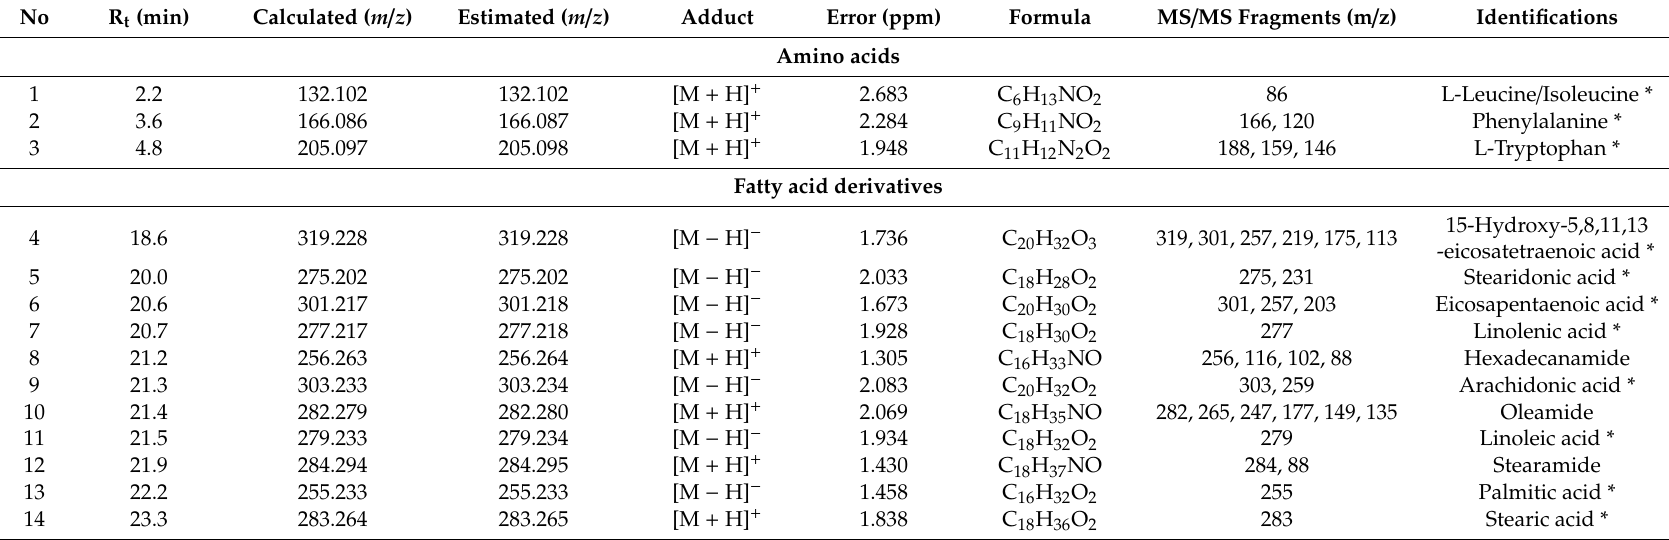
Table 1. Chemical characterization of LJWE constituents using ultra-performance liquid chromatography-tandem mass